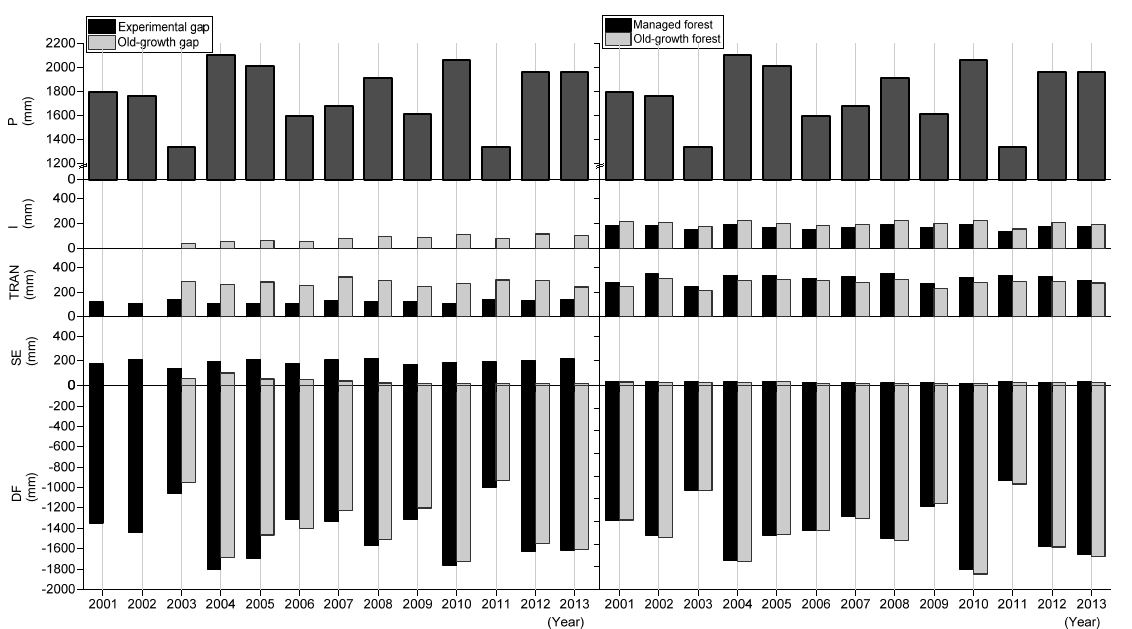
Figure 2. Annual precipitation (P), canopy interception (I), transpiration (TRAN), soil evaporation (SE), and drainage flux (DF) (mm) in gaps and forests in the Dinaric Karst from 2001 to 2013, except for the old-growth gap, for which the simulation ran from 2003 to 2013.